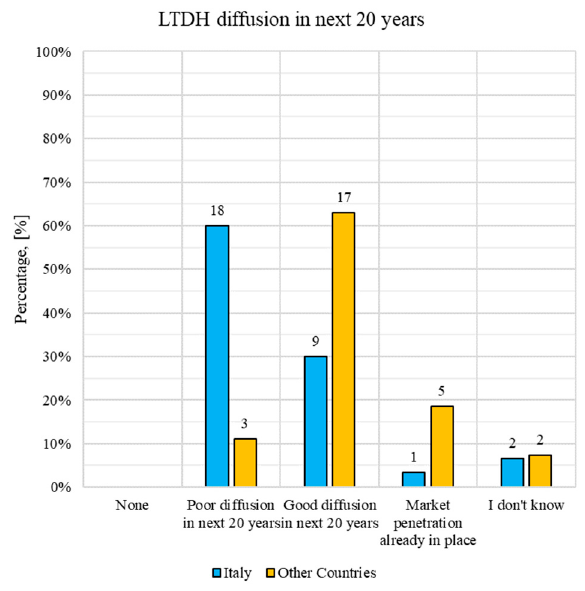
Figure 33 . LTDH concept diffusion over the next 20 years.